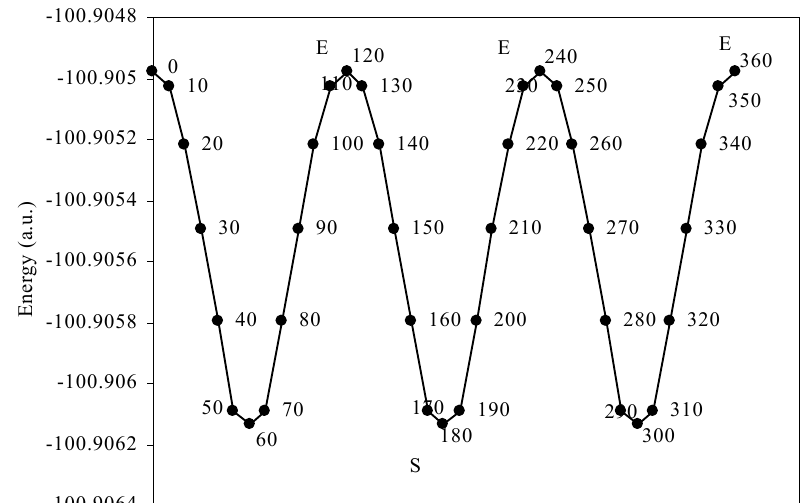
Figure 2. Plot of total energy of F (E-Eclipsed,